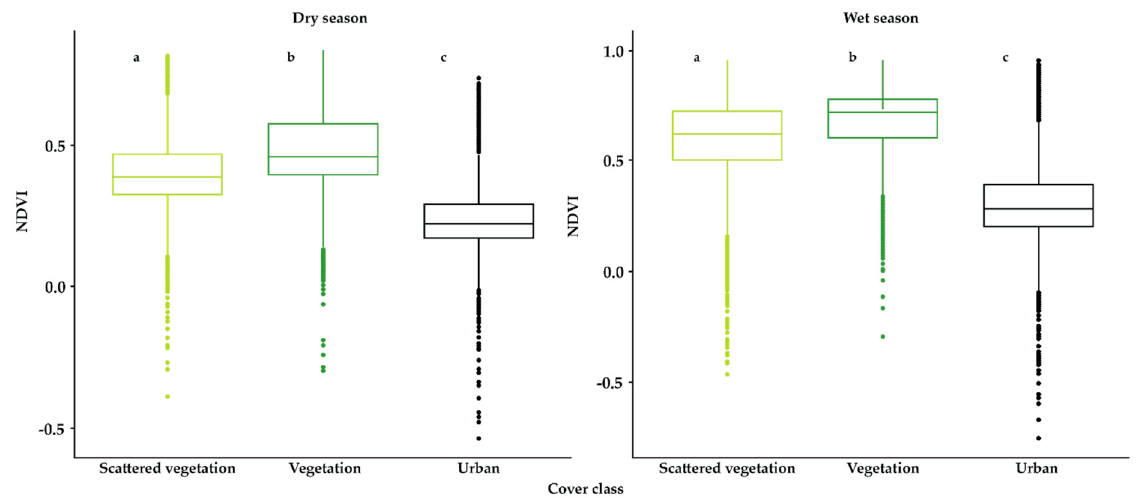
Figure 5. NDVI variation for land cover classes in the dry season ( left ) and the wet season ( right ), different letters show statistically significant differences.